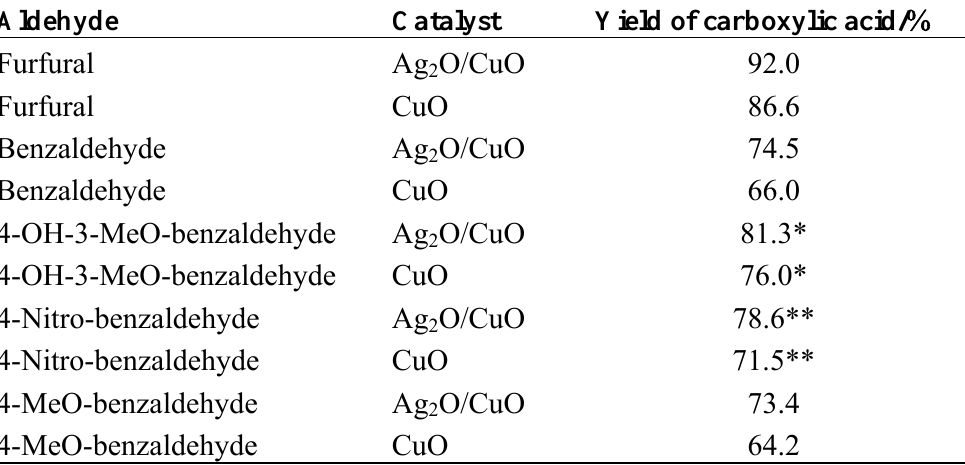
Table 1. Oxidation of aromatic aldehydes to corresponding carboxylic